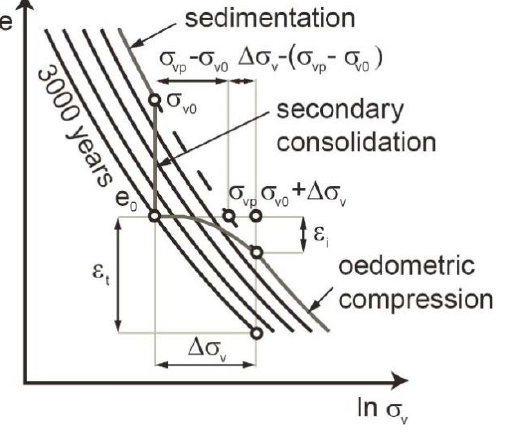
Figure 7: System of isochrones describing the compressibility characteristics of soft soils after Bjerrum [13].